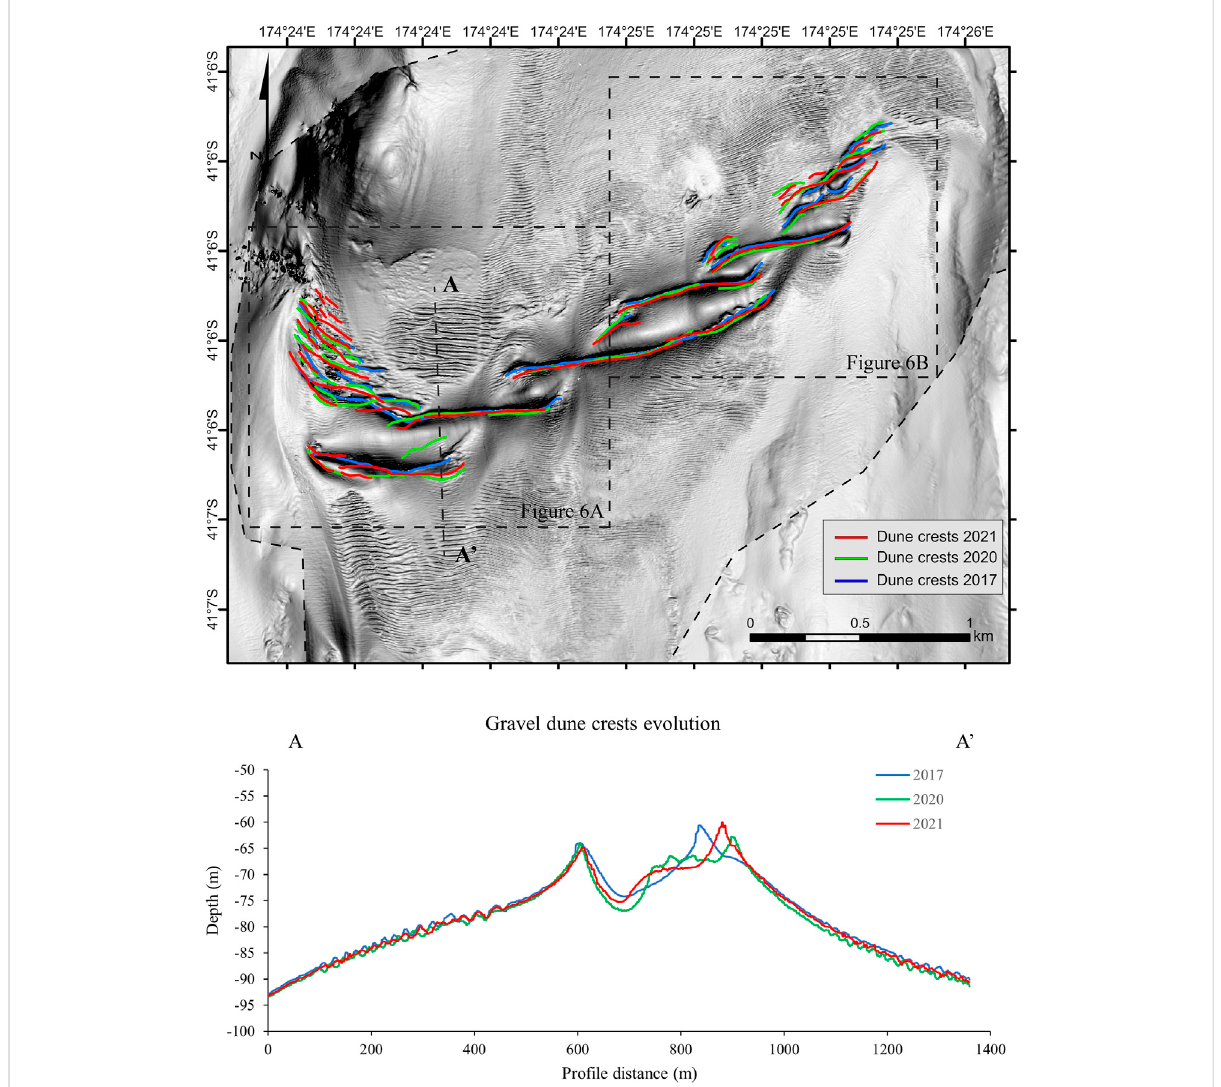
FIGURE 5 Morphologicalevolutionofdunesrepresentedbythedunescrestdigitisedonthethreemultibeammapsfromthe2017(blue),2020(green)and 2021 (red) surveys. Lower panel shows the bathymetric pro fi les (A-A ′ ) extracted from the three multibeam datasets. For depth information of the area, refer to Figure 3 showing depth contour lines (spaced 10 m). Greyscale shaded relief uses slope (rather than hillshade) to represent sea fl oor features, to reduce bias from arti fi cial light source elevation and